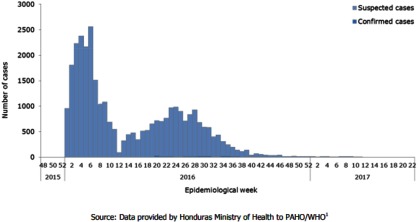
Suspected and Confirmed Zika Virus Cases, Honduras, Epidemiological Week 48 of 2015 to Epidemiological Week 22 of 2017Source: PAHO and WHO (2017).12